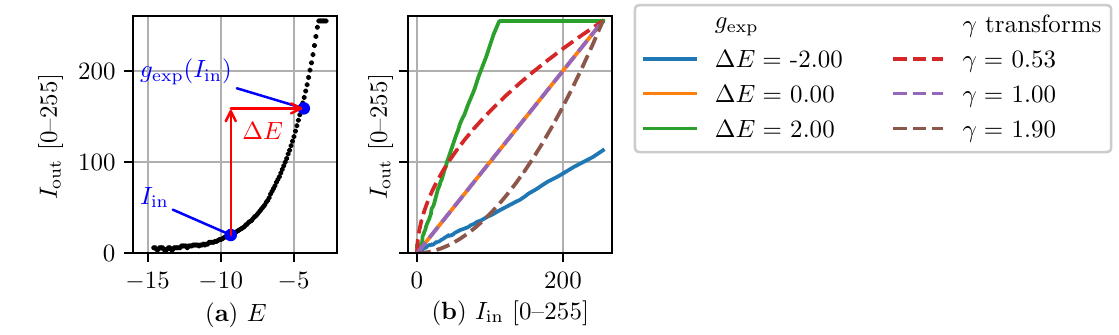
Figure 3. Example of a camera’s photometric response function and different corresponding g exp transformations: ( a ) The photometric response function of the camera relates the intensity of a pixel to its exposure level. For any given change in exposure ∆ E , a pixel intensity I in always has a corresponding transformed pixel g exp ( I in ) . ( b ) The g exp transformations relate the pixel intensity of an input image I in to its predicted intensity I out given a certain change in exposure level ∆ E . The mapping of these transformations is obtained directly from the camera’s photometric response function. Different γ transformations (15) are also shown for comparison.